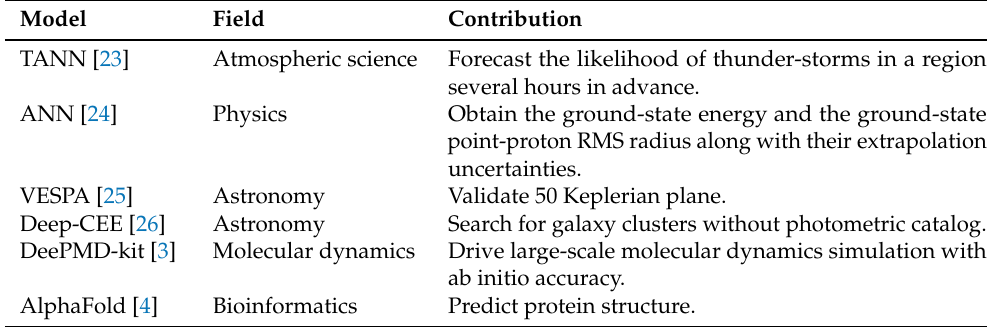
Table 1. Typical AI Models for